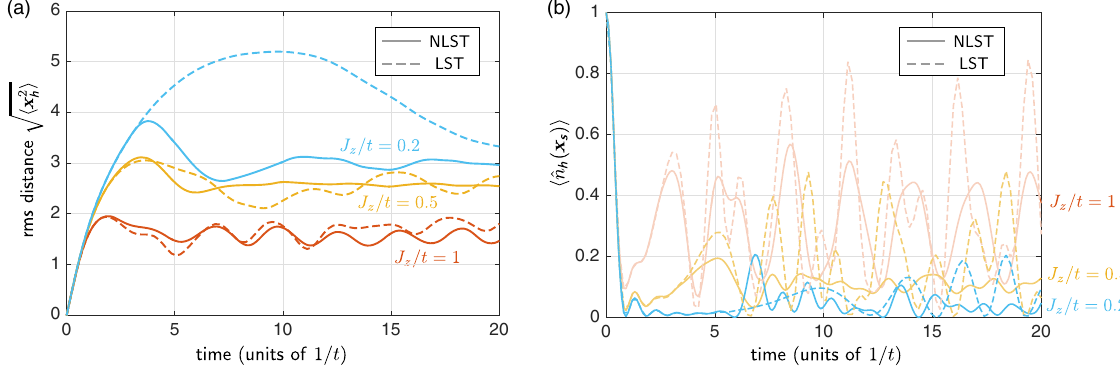
FIG. 25. Comparison of LST and NLST for S ¼ 1 /2. The starting point is a single hole created in the lattice by removing the central particle. (a) We calculate the rms radius of the hole density distribution as a function of time. Note that LST includes slow spinon dynamics, whereas NLST assumes a localized spinon for simplicity. In (b) we calculate the probability to find the spinon and the holon on the same lattice site. The maximum string lengths used are l